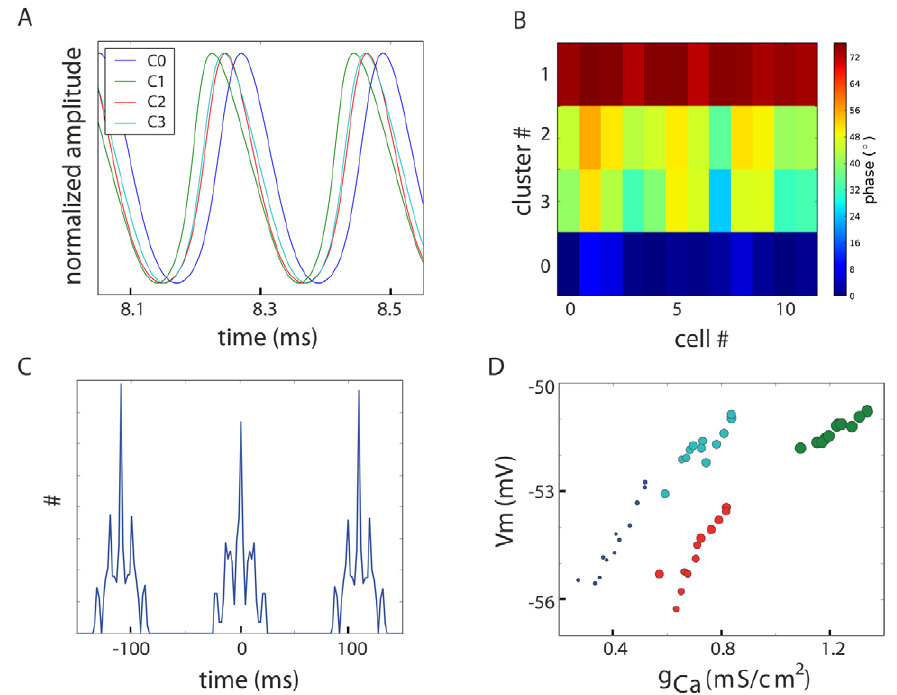
Figure 4. Stable phase differences between neurons. A: Focus on the normalized membrane potential of one neuron per cluster reveals that clusters with higher Ca 2 + -conductance are advanced in phase with respect to other clusters (traces have colors matching with Figure 1). In the regime of oscillatory IO neurons, higher Ca 2 + -density indicates a higher resting membrane potential that causes the neuron to lead in the phase. B: Phase- map color coding the phase-difference between all neurons in the network. Phase differences are given in degrees relative to the inter-peak-interval; the phase of the bottom left neuron is taken as reference (0 u ). Neurons within the same cluster have similar phases due to similar resting potentials, while larger phase-differences arise between clusters that are farther apart in terms of their conductances. The maximum phase-difference between two neurons was 72 u in the demonstration network. C: Cross-correlation of the peak times between (one neuron from the) four clusters computed for 5 s traces confirms that the phase-differences are stable over time. D: The amplitude and phase difference is proportional to the amount of g Ca - conductance a neuron contains. The y-axis denotes the peak voltage and the x-axis indicates the conductance density. The color-coding is the same as in A while the size represents the phase-difference (as measured between the neuron at the bottom left and any other